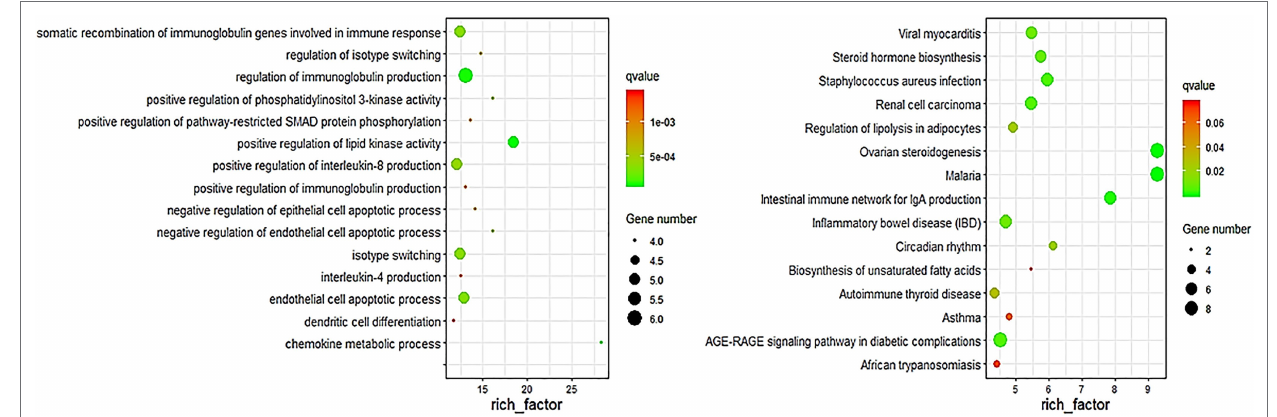
FIGURE 4 | Top 15 biological processes of GO enrichment and pathway enrichment.